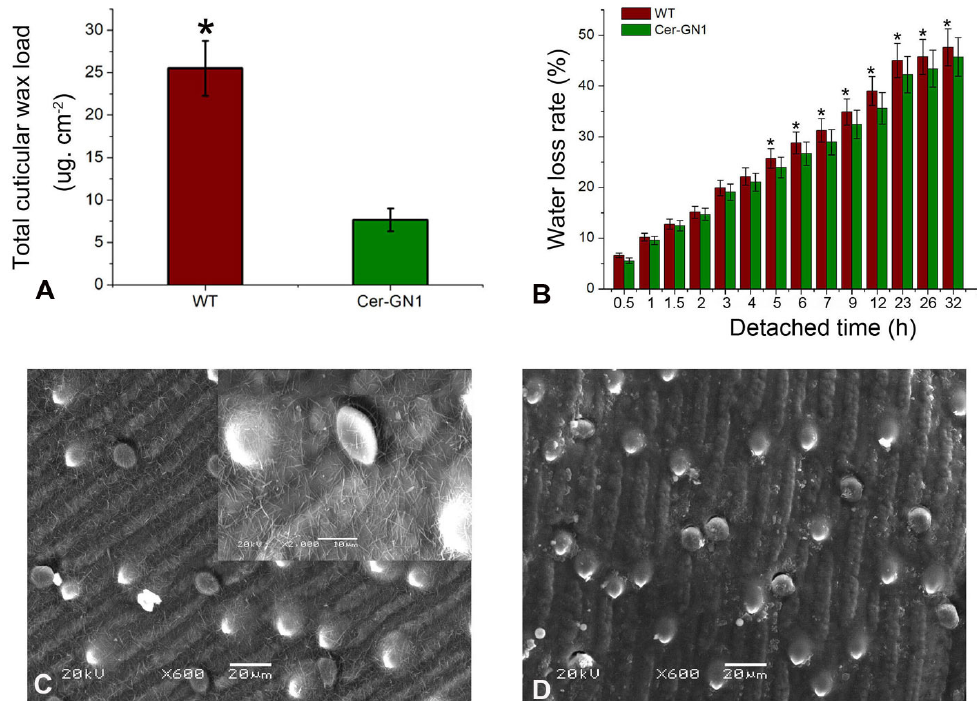
Figure 2. Cuticular wax variations of Cer-GN1 mutant and WT plants . The total cuticular wax load on the glume surface ( A ). Water loss rate ( B ). SEM of wax crystals on the glume surfaces of Cer-GN1 ( C ) and WT ( D ). Each value represents the mean of three replicates ± SD ( n = 3). * p < 0.05 by the Student’s t -test.